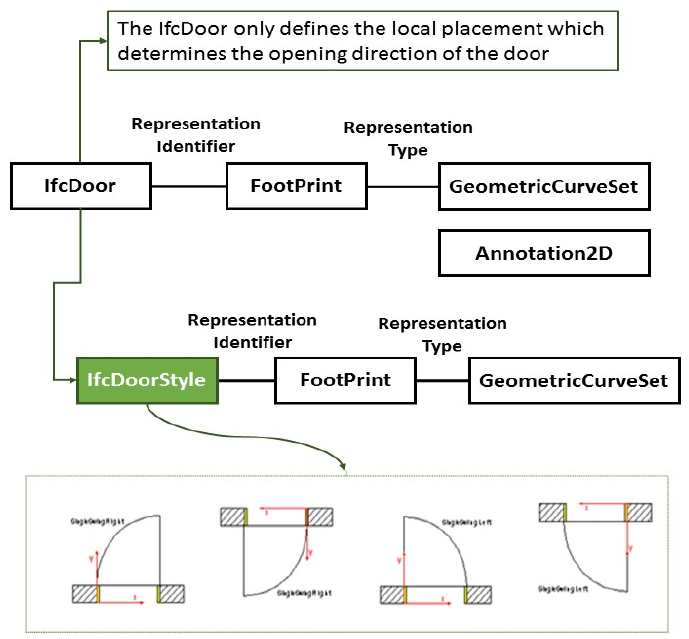
Figure 4. Derivation process of IfcDoor data.